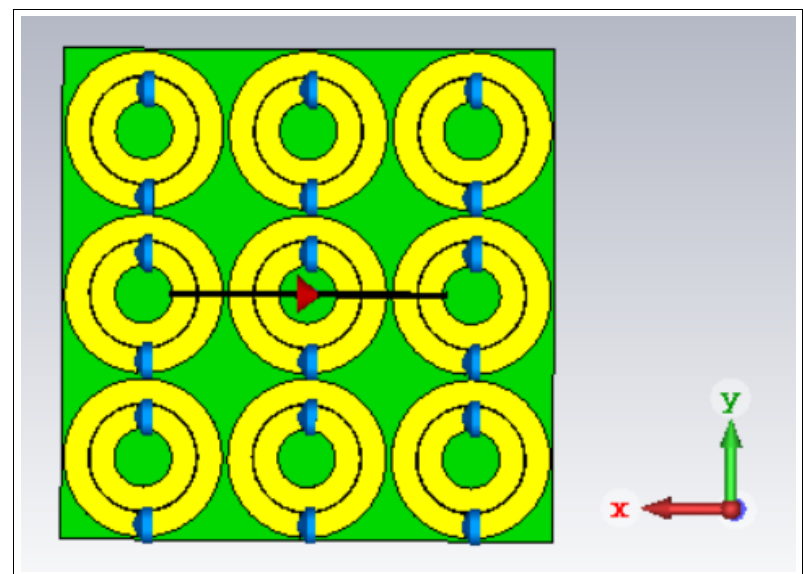
Figure 12. Dipole orientation and location in relation to the 9 SRR unit cell planar metastructure backed by an ENG layer of the same